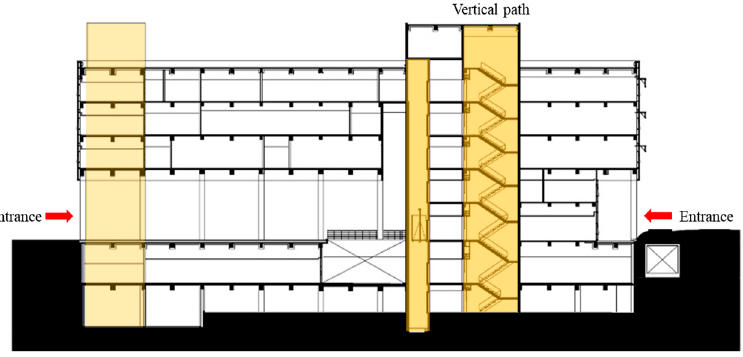
Figure 5. Cross-section of the reference building.